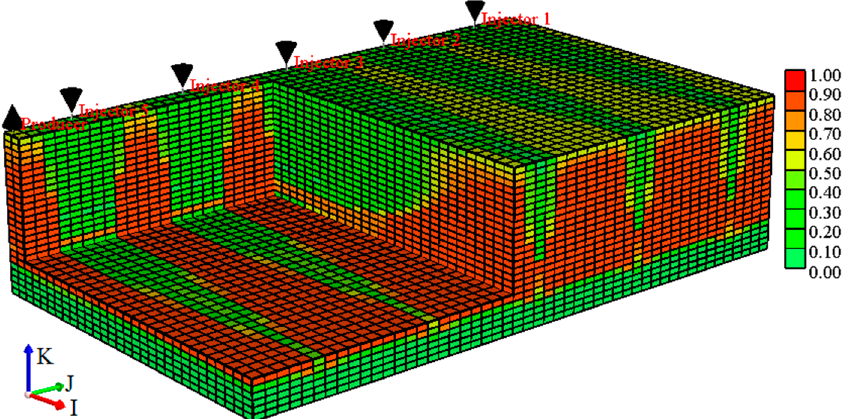
Figure 17. Oil distribution in the reservoir at the end of five years of production in the VInj-HPro well